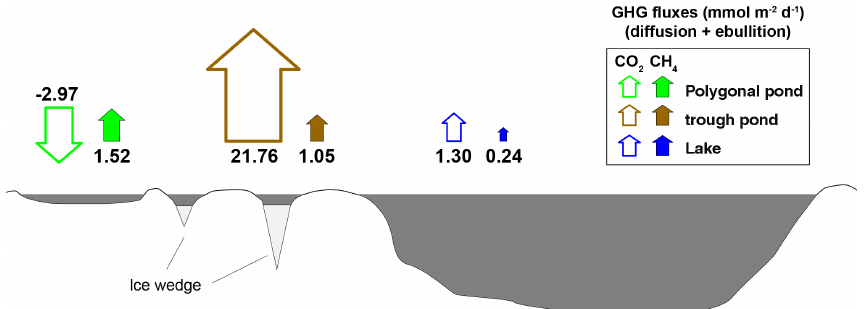
Figure 9. Schematic diagram of median fluxes of CO 2 and CH 4 from each type of water body in July. Note that dissolved and ebullition fluxes are combined (see Table 3 for